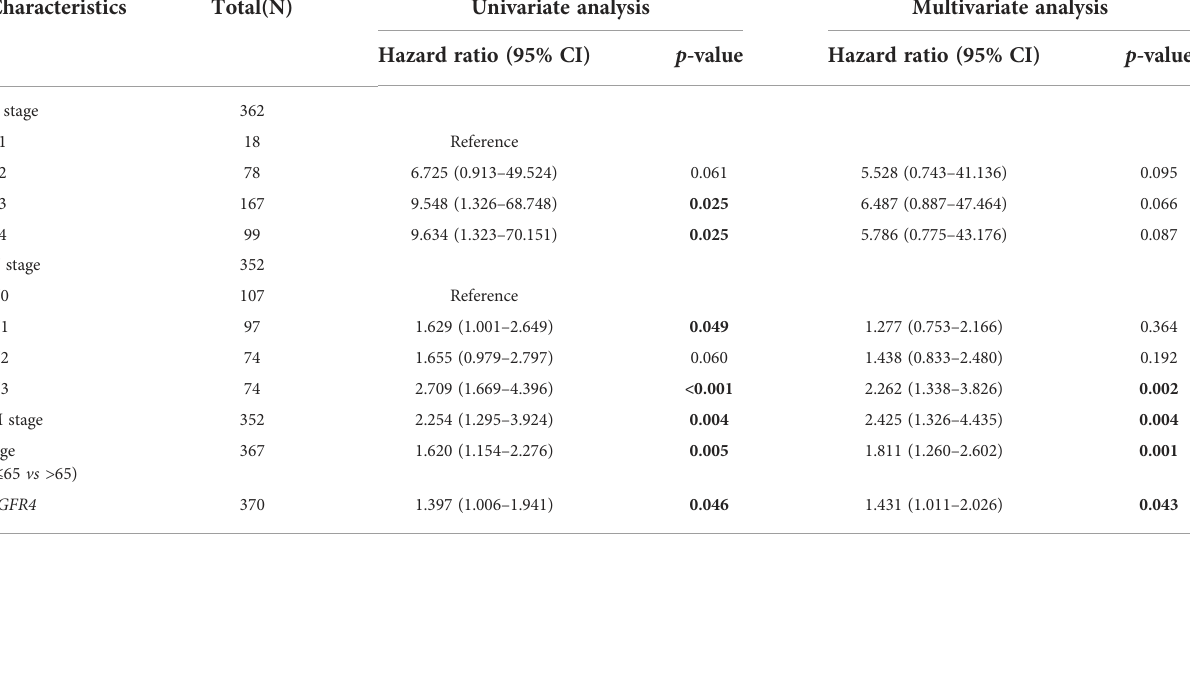
TABLE 1 Univariate and multivariate COX risk model.